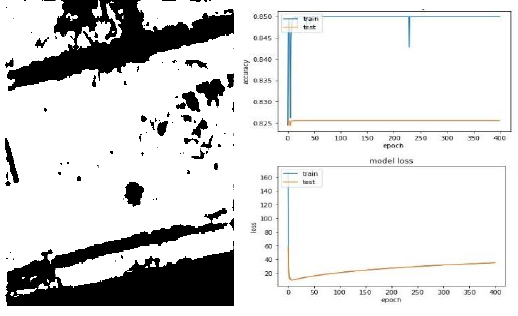
Figure 11 . Test 3 predictions: segmented image, model